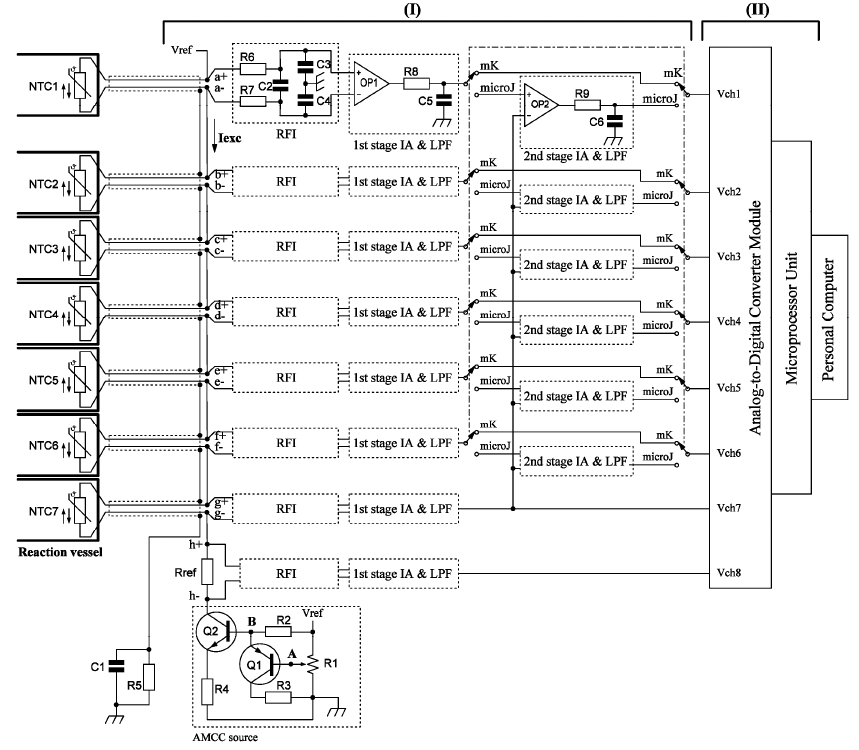
Figure 2. Schematic diagram of the signal processing unit including multiple ES signal conditioners (I) and a data processor (II).